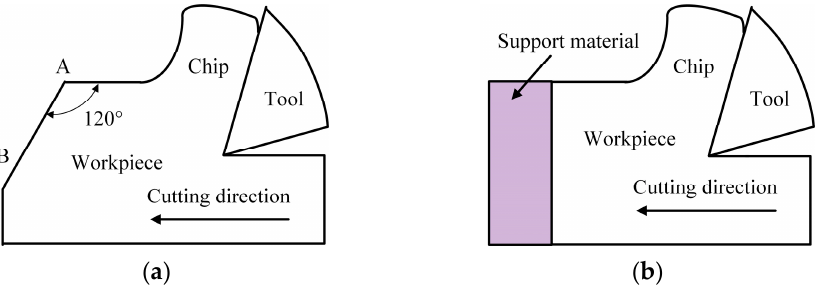
Figure 7. Support stiffness increasing methods. ( a ) Exit surface angle increasing. ( b ) Support mate- rial.